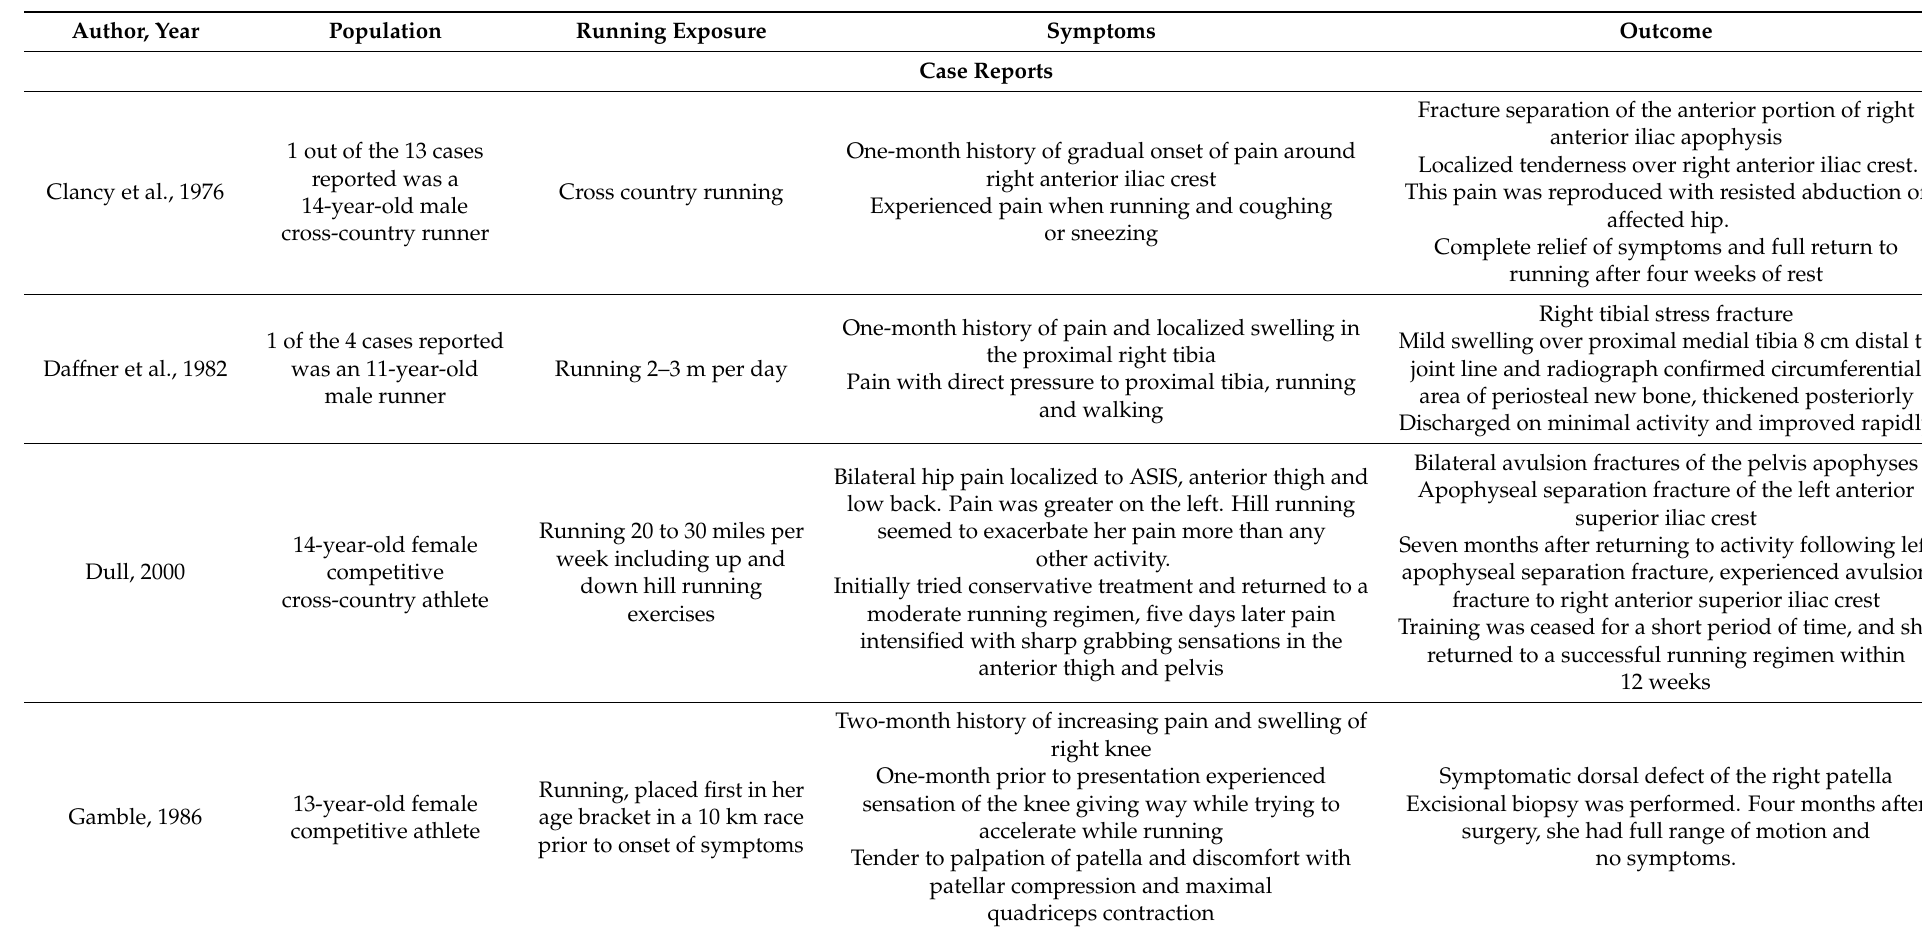
Table 2. Case Report